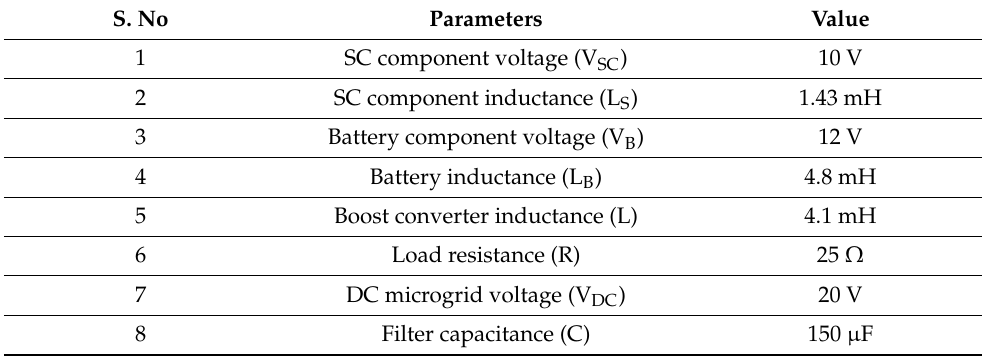
Table 6. Parameters for implementing a DC microgrid. S.